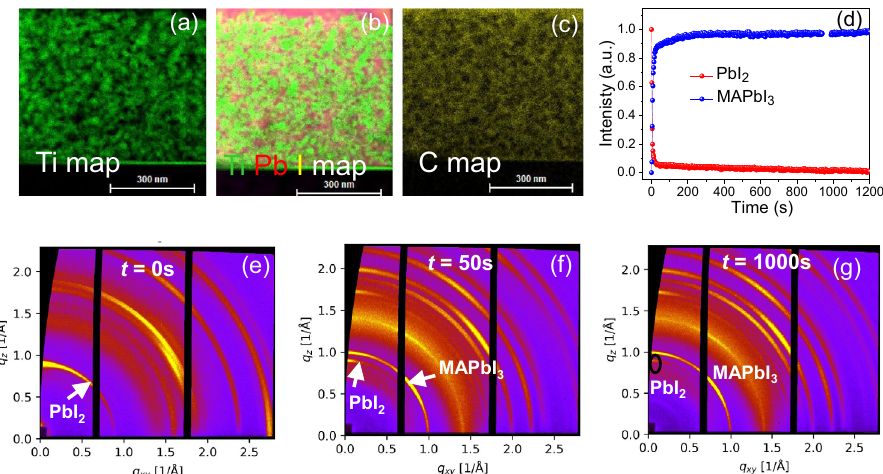
Fig. 1 Conversion reaction leading to the formation of MAPbI 3 within TiO 2 mesopores. a – c Scanning transmission electron microscope-energy dispersive spectroscopy (STEM-EDS) analysis for MAPbI 3 after conversion: a Ti map (showing cross-section of mesoporous TiO 2 fi lm). b Ti, Pb, and I map and c C map displaying in fi ltration of MAPbI 3 within the mesoporous TiO 2 fi lm. d Absolute Bragg peak intensity against the time of the MAPbI 3 conversion reaction: integrated intensity vs time of the consumption of PbI 2 (red trace) and formation of MAPbI 3 (blue trace). The intensities of the most intense Bragg re fl ections were integrated, normalized and plotted against time. Reciprocal maps of the PbI 2 + MAI perovskite conversion reaction at e 0 s f 50 s and g 1000 s after the MAI- isopropyl alcohol solvent was